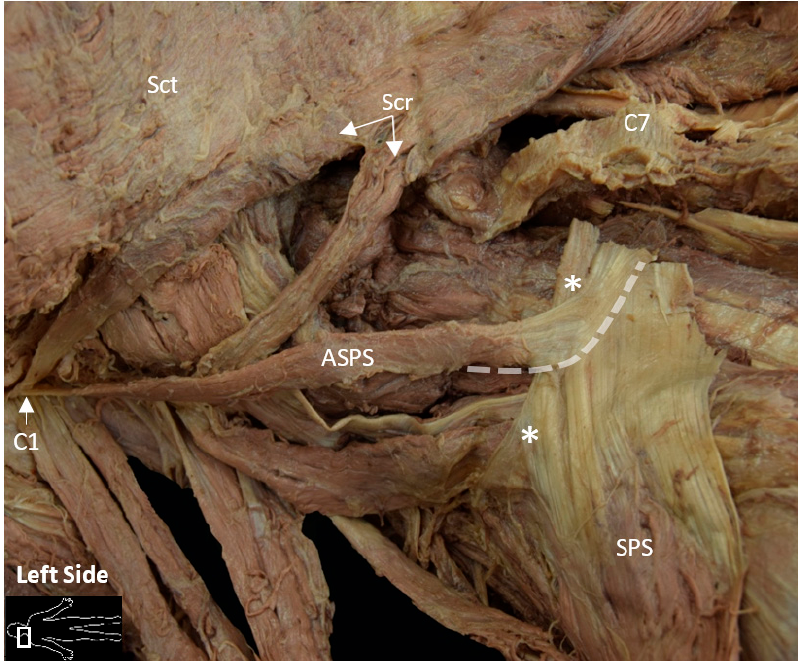
Figure 2. Origin and Insertion Sites for ASPS. The dashed line illustrates the slightly perpendicular insertion of the ASPS onto the proximal portion of the SPS. Asterisks indicate the upper tendinous connection of the SPS traveling deep to the ASPS. Accessory Serratus Posterior Superior (ASPS) Muscle; Atlas transverse process (C1); Spinous process of cervical vertebra 7 (C7); Serratus Posterior Superior (SPS) Muscle; Splenius capitis (Sct) Muscle; Splenius Cervicis (Scr) Muscle.